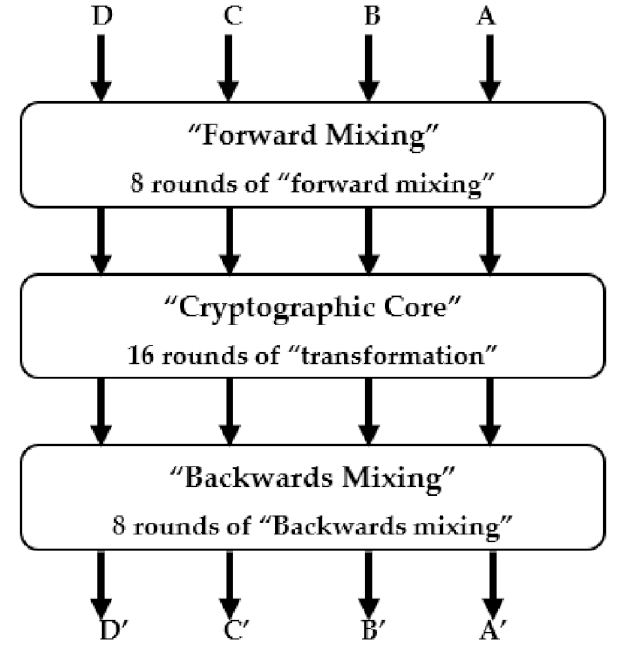
Figure 1. High-level structure of MARS encryption